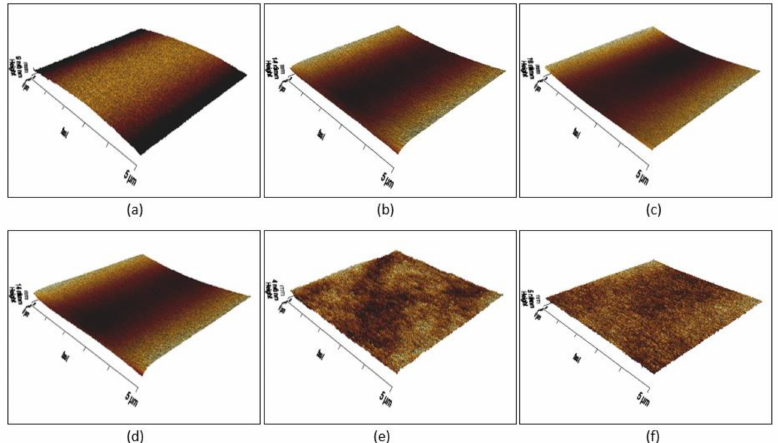
Figure 6. Atomic force microscopy (AFM) of the UV-LED curable polyurethane coating: ( a ) pristine PUA; ( b ) FPUA-2; ( c ) FPUA-4; ( d ) FPUA-6; ( e ) FPUA-8; and ( f ) FPUA-10.